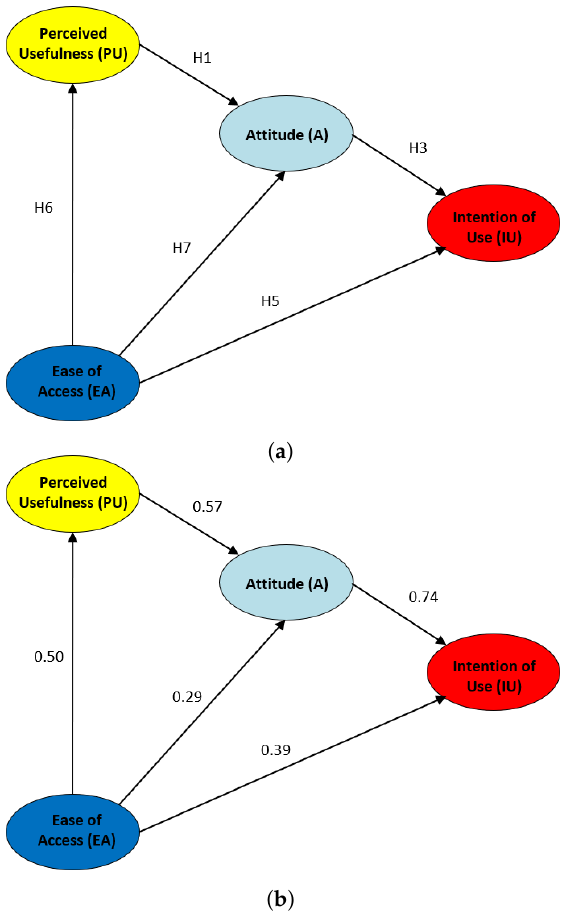
Figure 11. Proposed improved UTAUT model for the CVL Technology. ( a ) Hypotheses (H1, H3, H5, H6, H7) ( b ) Influence among